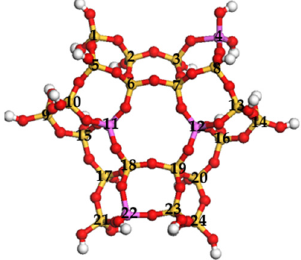
Figure 3. The stable cluster geometry of Y 4 − zeolite with 24T atoms. See Figure 2 for the color coding.